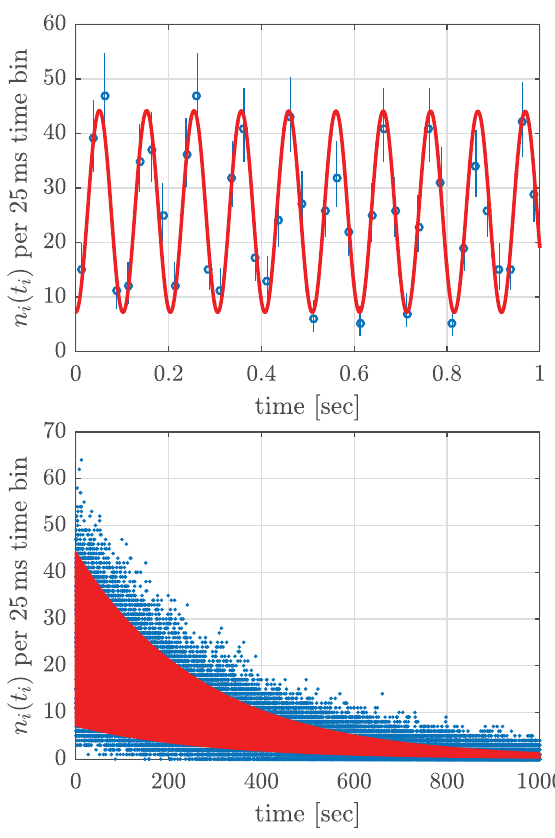
Figure 2. Example of a Monte Carlo simulation of the scintillation event rate vs. time data during the free precession period of a single free precession measurement cycle. The events are time binned, with n i ( t i ) being the number of events that fall within a time bin centered at time t i . The parameters used are described in the text. The best fit curve is shown in red. The upper plot is zoomed in on the first 1s, with the error bars shown as the 67% C.I. for a Poisson distribution. The lower plot is of the entire period and without error bars on the